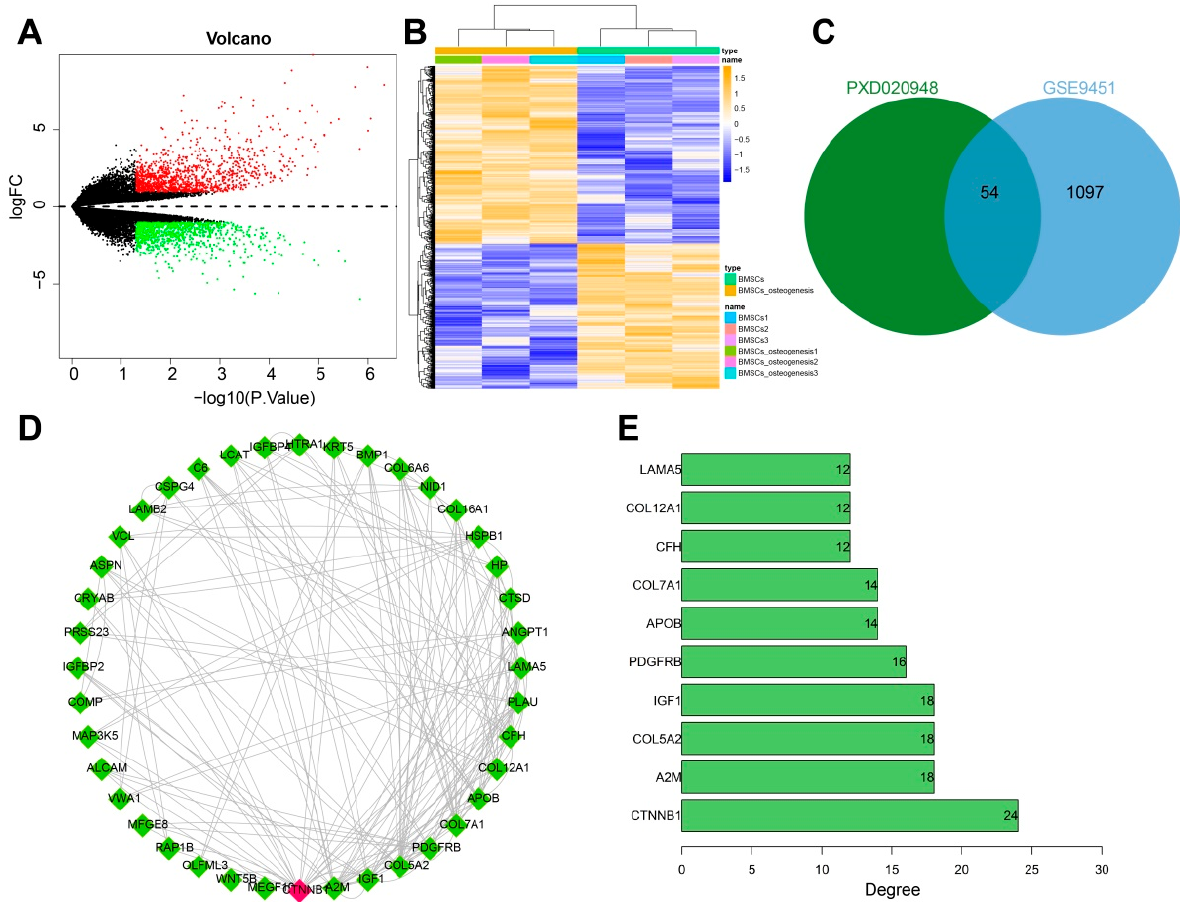
Figure 2. Screening of key genes for BMSC–Exos to promote BMSC osteogenic differentiation. ( A ) The volcano plot for differential analysis of GSE9451 dataset. Red dots indicate significantly upregulated genes, green dots indicate significantly downregulated genes, and black dots indicate genes not differentially expressed (BMSCs group: n = 3; BMSCs osteogenesis group: n = 3). ( B ) Heatmap for differential analysis of GSE9451 dataset (BMSCs group: n = 3; BMSCs osteogenesis group: n = 3). ( C ) Venn diagram for the intersection of PXD020948 and GSE9451 datasets. ( D ) Protein interaction diagram of the 54 candidate genes, in which the counterclockwise degree values were sequentially decreased from CTNNB1. ( E ) The top 10 genes displayed according to the degree values.